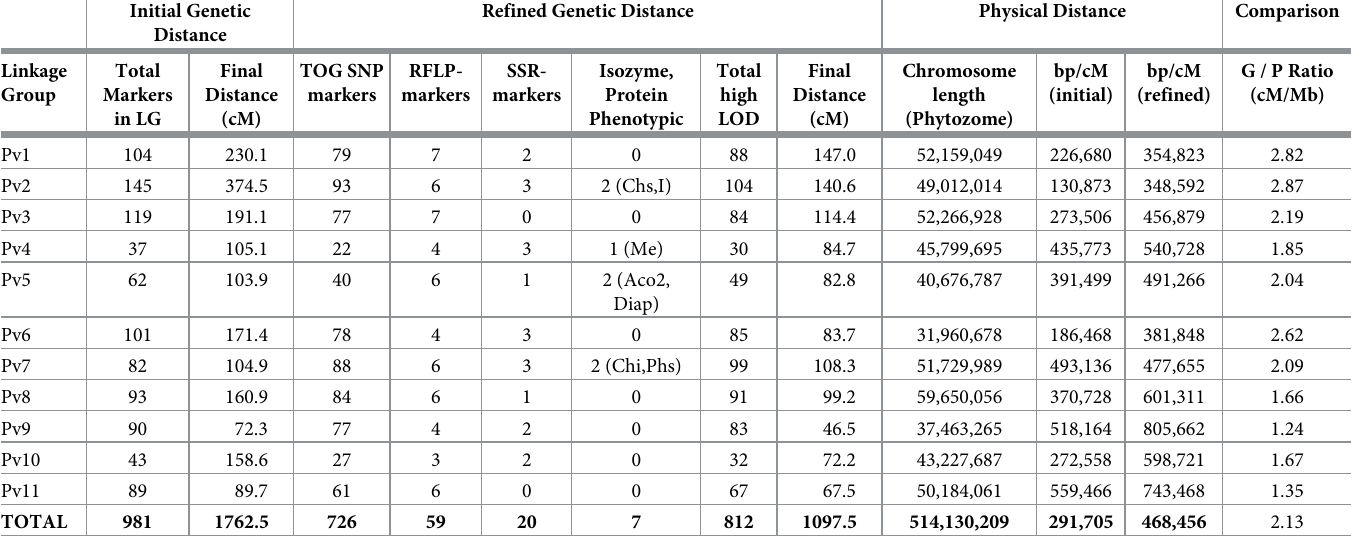
Table 1. Physical and genetic mapping and map distance in base pairs (bp) or centiMorgans for each linkage group on the G19833 reference genome v 2.1 or in the BAT93 x Jalo EEP558 population, respectively, using SNP markers from the trans-legume orthologous genes (TOG) combined with other types of markers, includ- ing restriction fragment length polymorphism (RFLP) markers of the Bng and D series, simple sequence repeat (SSR) markers and isozyme, protein or phenotypic markers. Initial Genetic Refined Genetic Distance Physical Distance